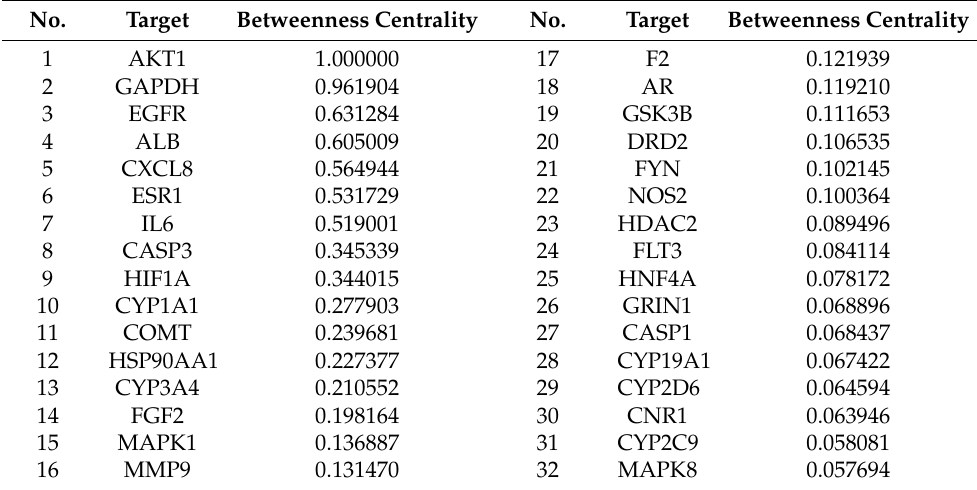
After screening the top 30% in terms of betweenness centrality (BC) of the subnetwork, which comprised 32 nodes and 254 edges (Table 3) (Figure 3). Table 3. The degree of the top 30% BC targets from Table 1.